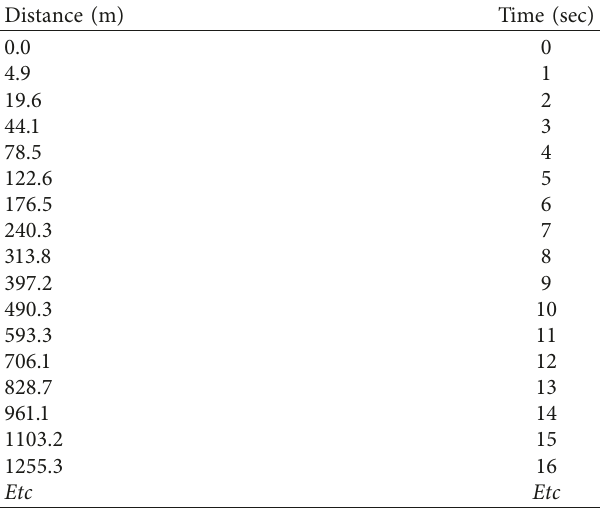
Table 1: The distance (in metres) travelled by a falling object in a given time (in seconds) since it started to fall.